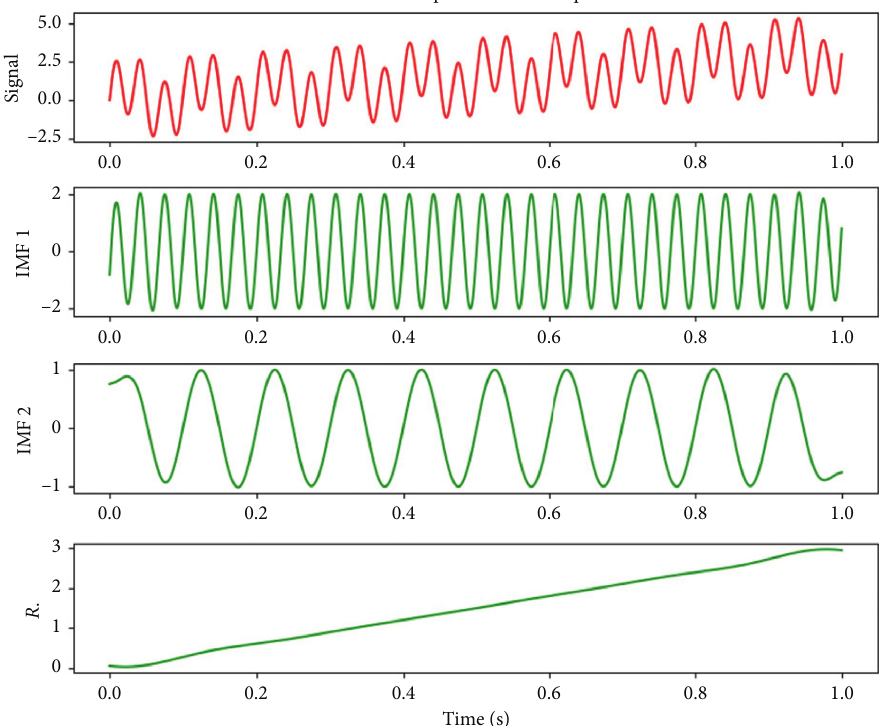
Figure 5: The sequences of sin signal decomposed by the EEMD.